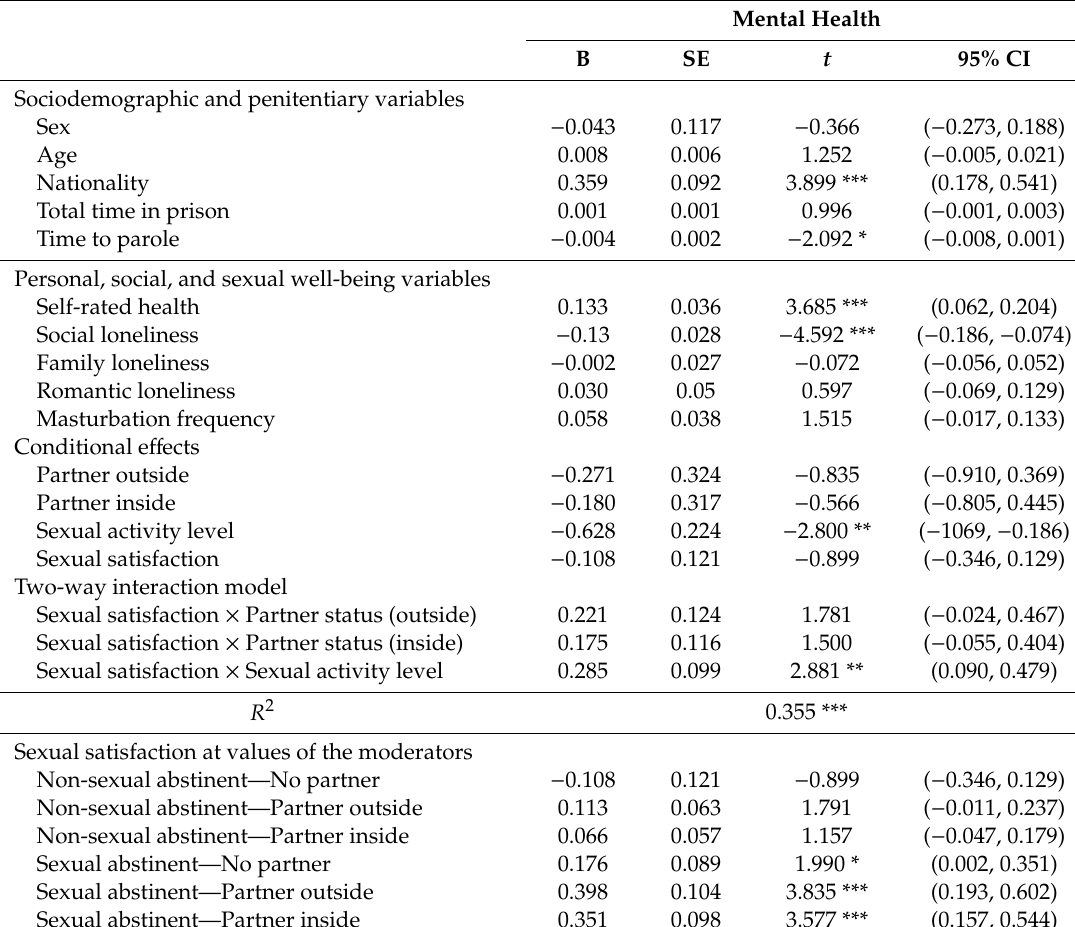
Table 2. Multiple regression analysis on mental health and conditional e ff ects of sexual satisfaction at values of the moderators (partner status and sexual activity